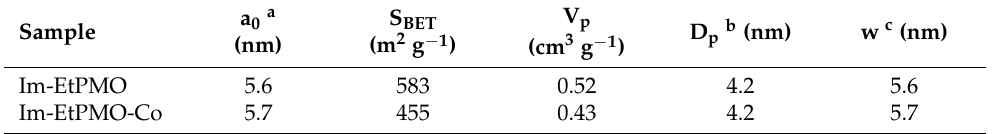
Figure 3. Nitrogen adsorption–desorption isotherms and pore size distributions (inset) of Im-EtPMO (red line) and Im-EtPMO-Co (blue line). Table 1. Physicochemical properties of Im-EtPMO and Im-EtPMO-Co materials.